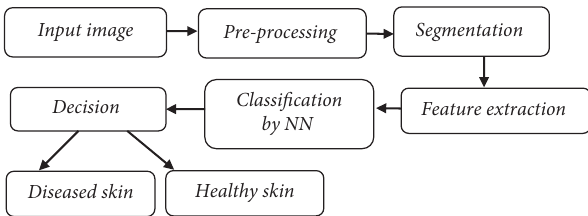
Figure 3: General models for skin classification within existing studies.